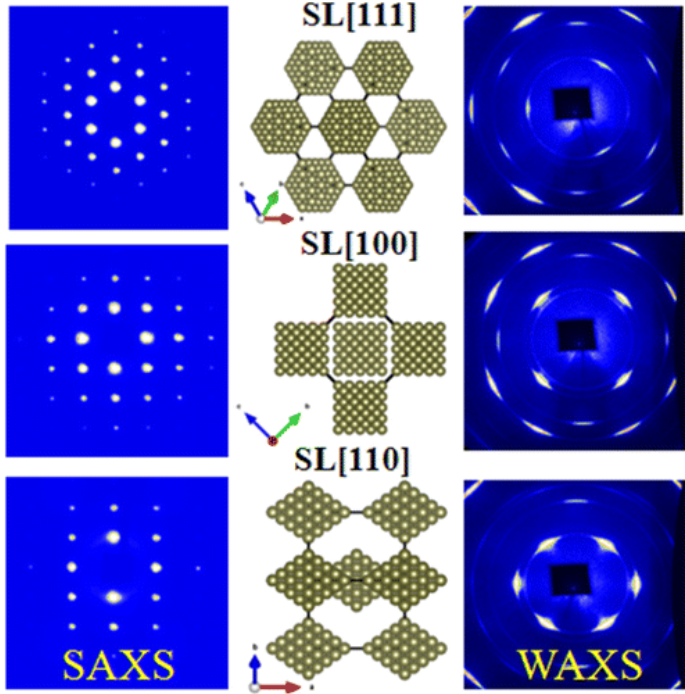
Figure 3. Representative SAXS and WAXS images and reconstructed structural details of single body-centred cubic (bcc) supercrystal made up of octahedral Pt 3 Ni NCs [40]. The three panels represent SAXS images of supercrystal collected from SL [111], SL [100] and SL [110] orientations ( Left ), respectively, WAXS images collected from the corresponding superlattice orientations ( Right ), and reconstructed structures at the three above-defined crystallographic directions ( Middle ). Copyright of the American Chemical Society [40].